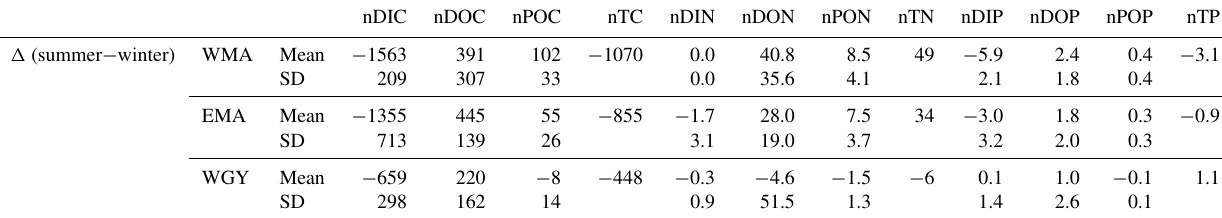
Table 8. Estimated temporal evolution of (0–70m) biogeochemical inventories between austral winter and summer in mmolm − 2 presented in columns: (1) Mean measurements at 70m depth during OUTPACE were considered to represent the homogeneous upper water column (0– 70m) variables and initial winter conditions (i.e., conditions in July 2014). The summer conditions were those observed during the OUTPACE cruise (March 2015). (cid:49) represents the summer minus winter conditions differences. (2) Selected area: western Melanesian Archipelago (WMA), eastern Melanesian Archipelago (EMA), or western gyre (WGY). (3) Mean or standard deviation (SD), (4 to 15) dissolved inorganic (DI), dissolved organic (DO), particulate organic (PO), and total (T) C, N, and P, respectively. All variables were normalized to the mean absolute salinity measured at 70m depth to discard evolution due to evaporation or